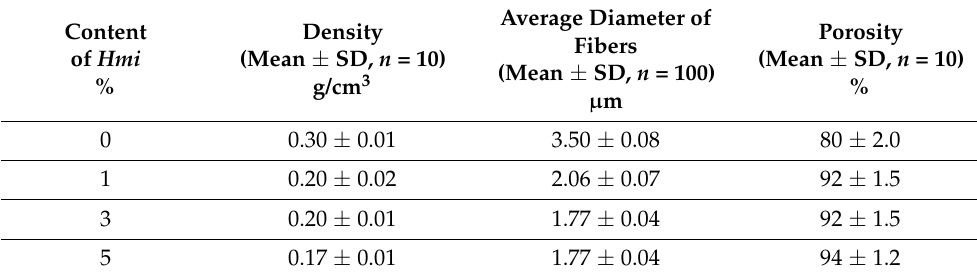
Table 1. Structural characteristics of PHB and Hmi /PHB nonwoven